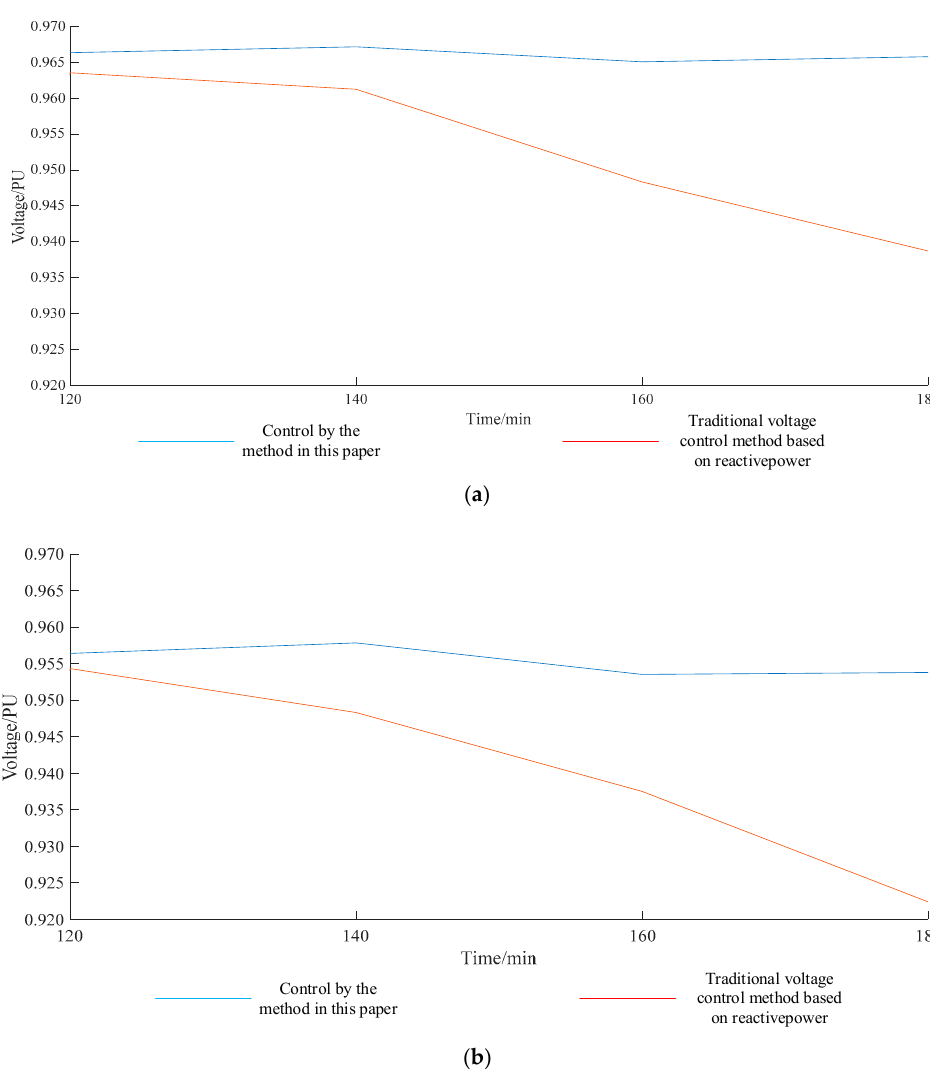
Figure 10. Comparison of the control effects: ( a ) AR 5 bus 17 voltage and ( b ) AR 3 bus 31 voltage.